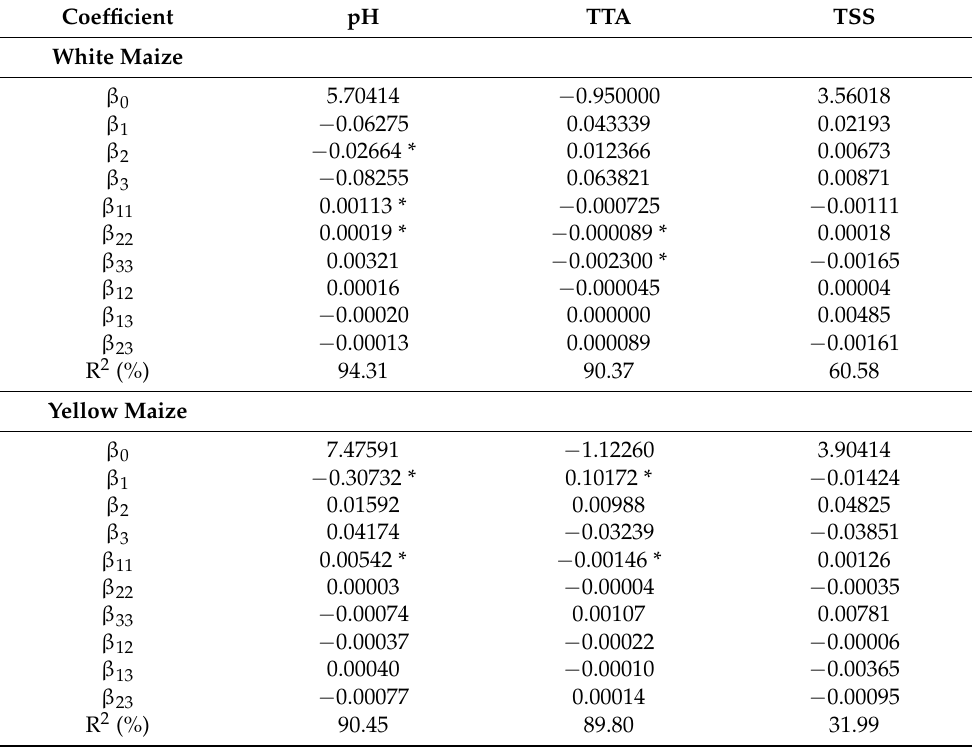
Table 3. Coefficient of regression for the different mathematical model equations obtained for mahewu produced with white and yellow